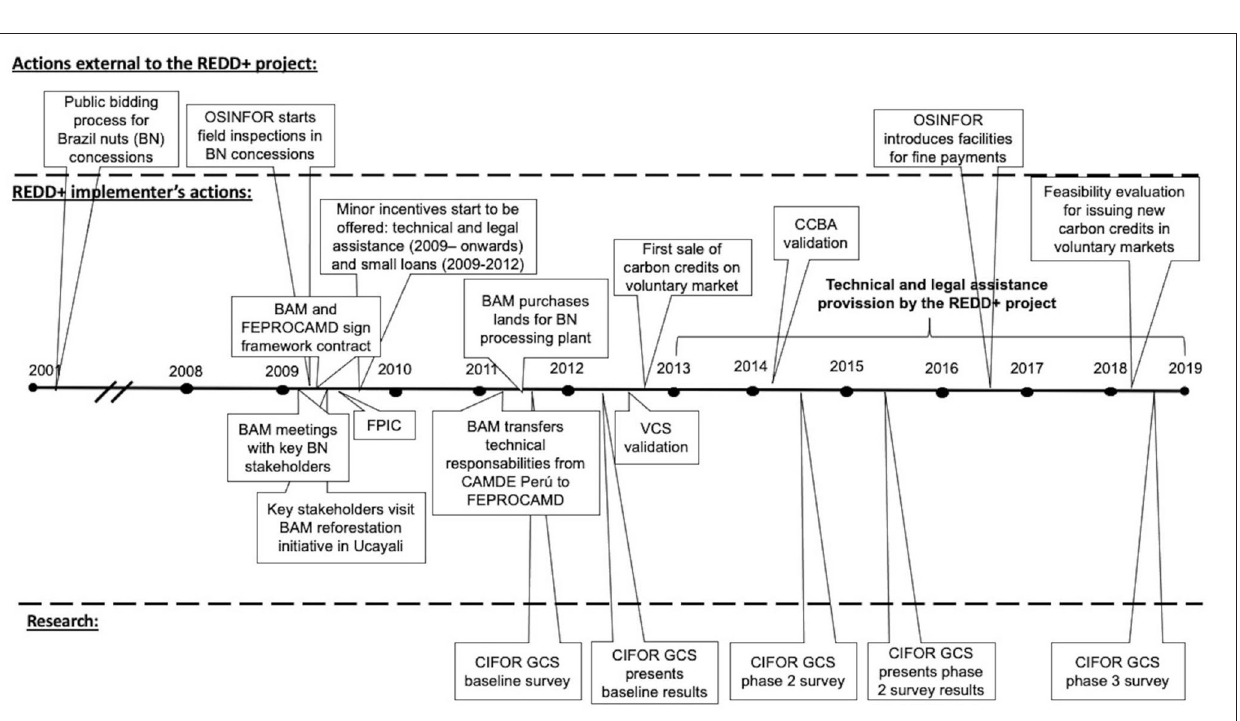
FIGURE 2 | Theory of Change of Madre de Dios REDD + with simultaneous law enforcement. Own elaboration based on implementer interviews and project documents.